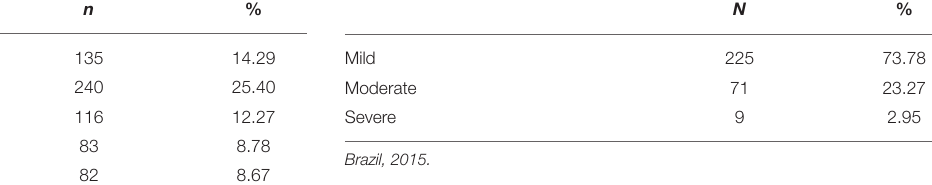
TABLE 1 | Distribution of anesthesiologists that answered the questionnaire ( n = 945) by the duration of anesthesia practice ( n , %). Time of practice of anesthesia